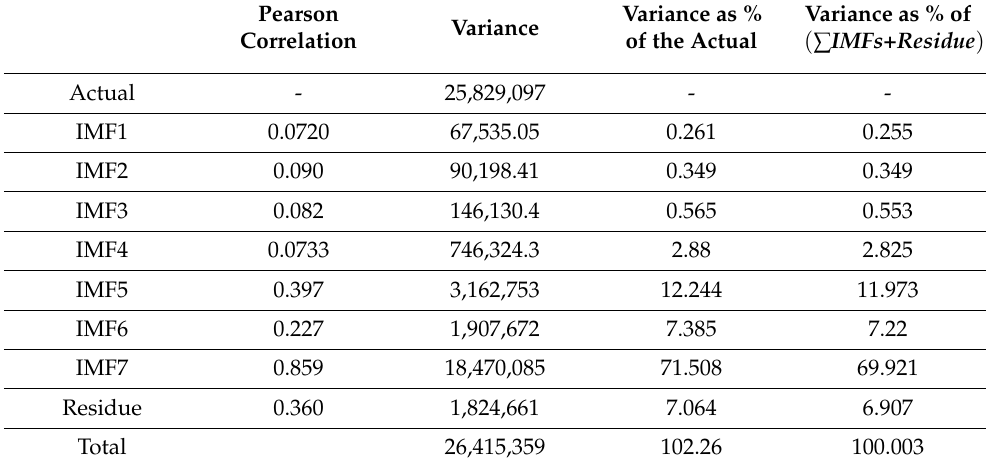
Table 5. Statistical measures of IMFs and residue extracted by implementing